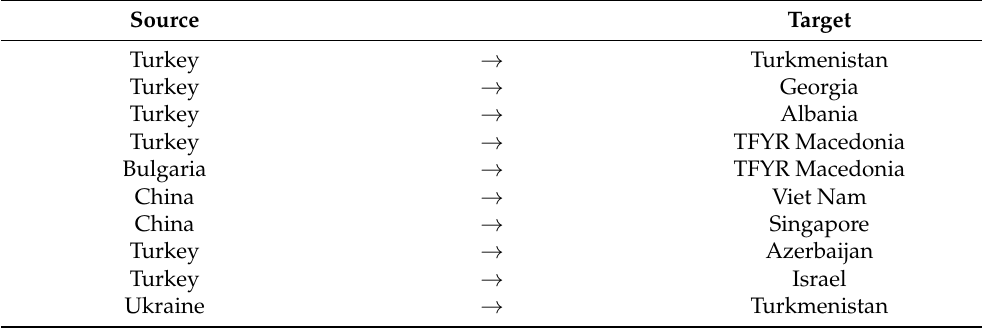
Table 3. Top 10 EGSR flow relationships at the national level.